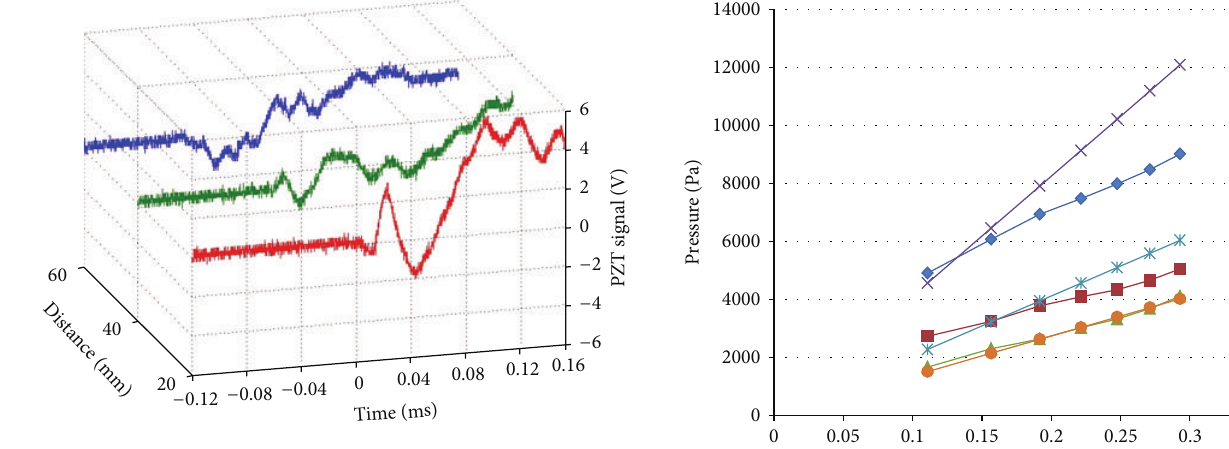
Figure 12: First packet of wave output voltage from PZT sensor.